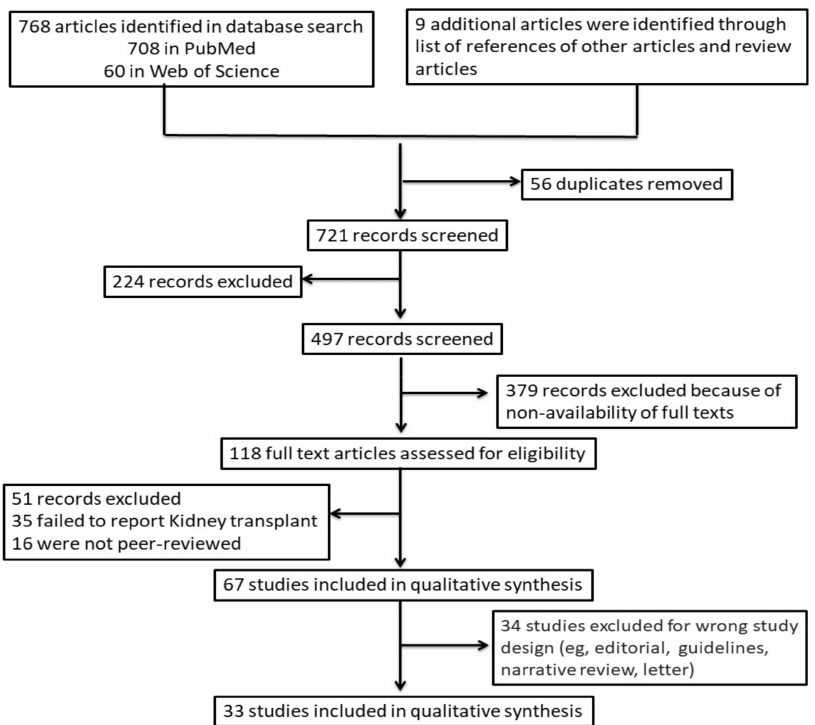
Figure 1. PRISMA flow diagram of included